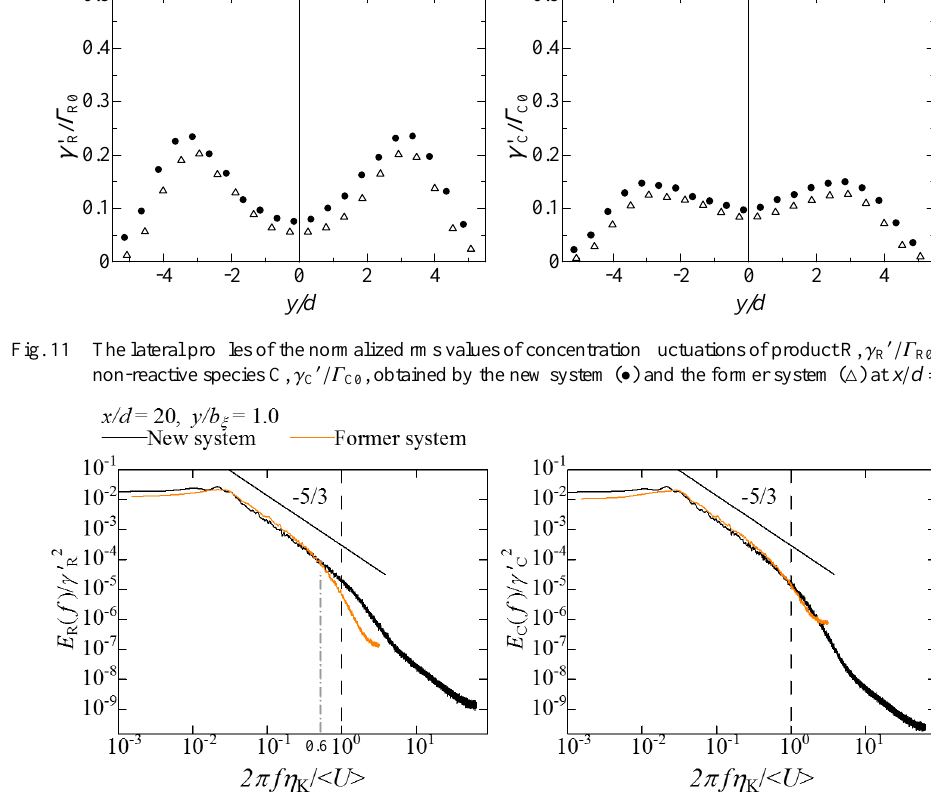
Fig. 12 The normalized power spectra of concentration fluctuations of product R, E R ( f ) =(cid:13) R ′ 2 , and non-reactive species C, E C ( f ) =(cid:13) C ′ 2 , obtained by the new system (black lines) and the former system (orange lines) at x = d = 20 and y= b (cid:24) = 1 : 0. The wavenumber 2 (cid:25) f = ⟨ U ⟩ is normalized by the Kolmogorov wavenumber 1 =(cid:17) K